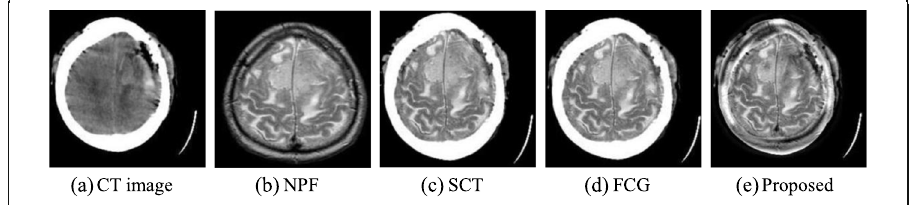
Fig. 6 CT/fusion image of meningioma. a CT image. b NPF. c SCT. d FCG. e